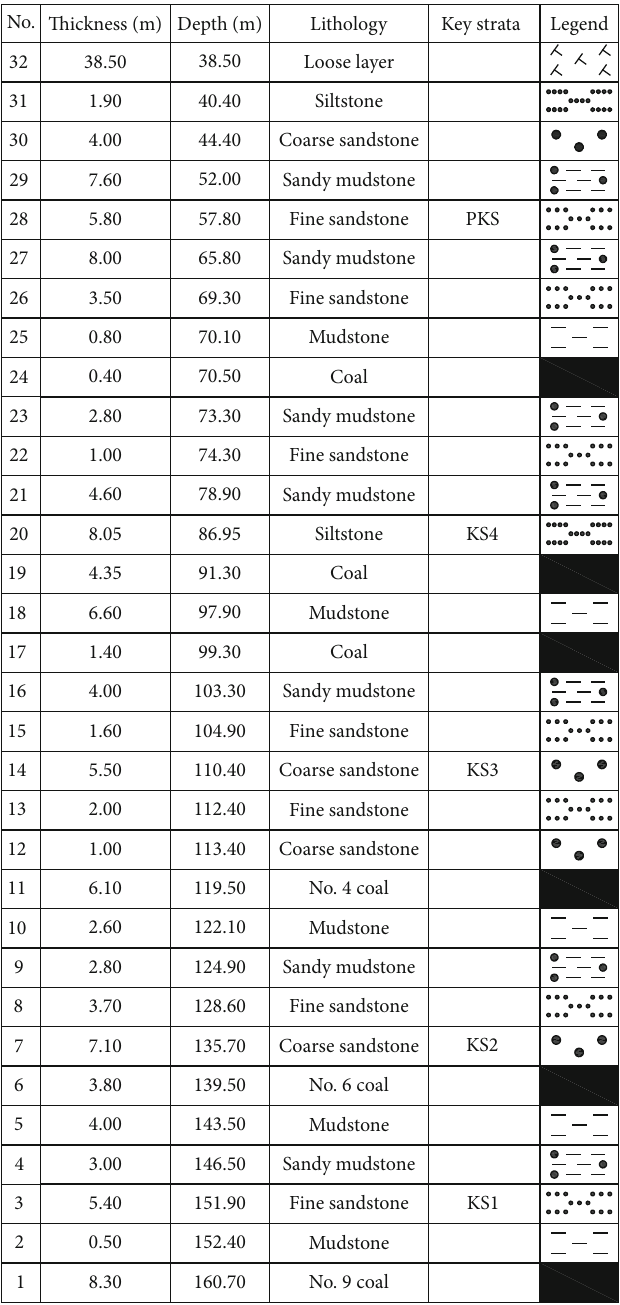
Figure 3: Location of key strata of the no. 6107 working